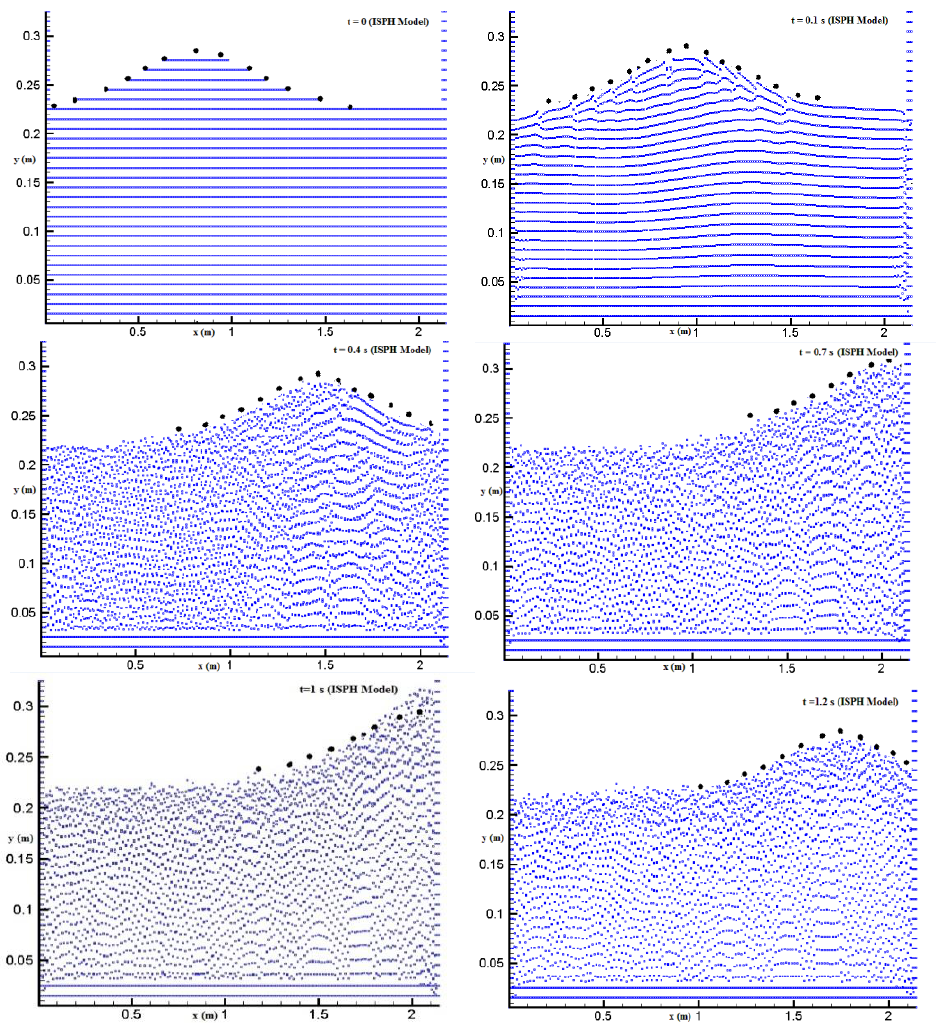
Figure 10 Comparisons of modeled (the blue points) and analytical (the black points) solitary wave profiles at 0.1, 0.4, 0.7, 1 and 1.2 s.